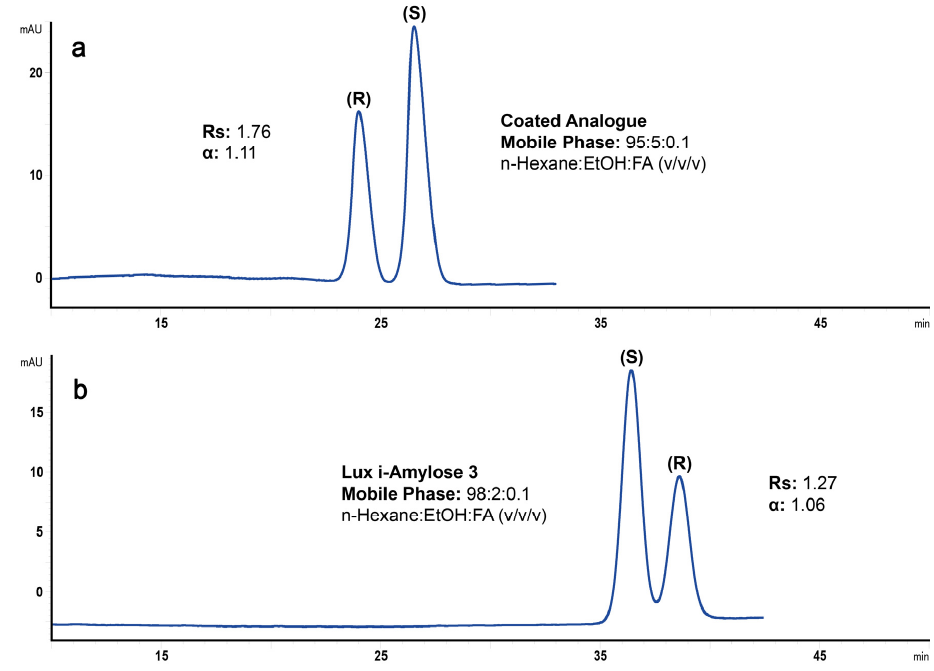
Figure 3. Separation of R - and S -ketoprofen mixture (1 / 2 ratio, w / w ) on amylose tris(3-chloro-5-methylphenylcarbamate)-based chiral columns (250 × 4.6 mm, 5 µ m) with coated ( a ) and immobilized ( b ) chiral selectors. Separation temperature was 25 ◦ C, flow rate was 2 mL / min, detection was performed at 254 nm with the mobile phase composition of n-hexane:ethanol:formic acid, 95:5:0.1 ( v / v / v ) for the coated ( a ) and n-hexane:ethanol:formic acid, 98:2:0.1 ( v / v / v ) for the immobilized ( b ) chiral selector.